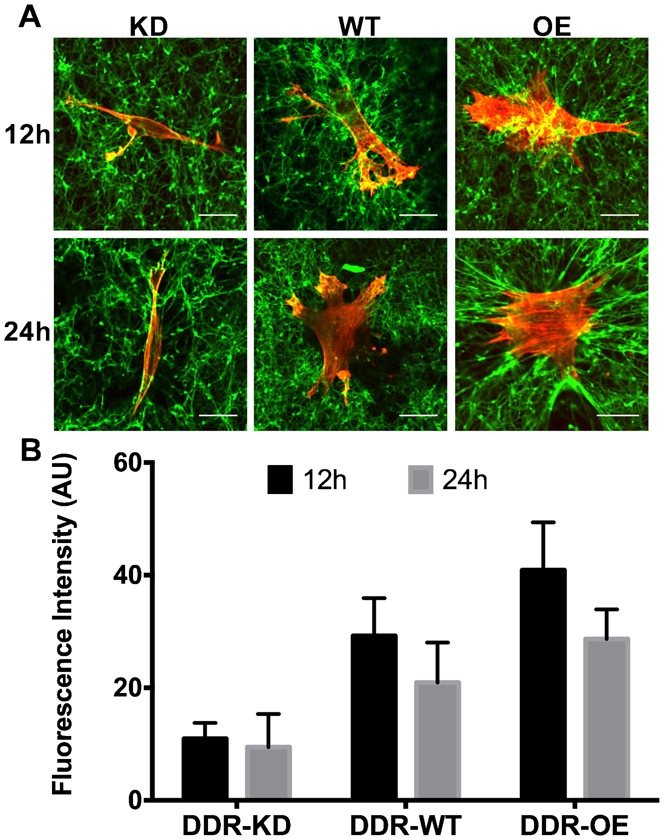
DDR1 over-expression enhances collagen fibril reorganization.(A) Knockdown (KD), wild type (WT) or DDR1 over-expressing (OE) cells were cultured on FITC-labeled fibrillar collagen gels for 12 h (upper panel) or 24 h (lower panel) to evaluate morphologically, collagen remodeling. Bar = 20 µm; (B) Quantification of FITC-collagen fluorescence in fixed area regions of interest by image analysis using Image J. Mean fluorescent intensity was obtained from average fluorescence intensities normalized to data of same gels without cells. At least 4 representative images were analyzed for each condition. Data are mean±standard errors of fluorescence intensity in arbitrary units (AU) in sampling grids.